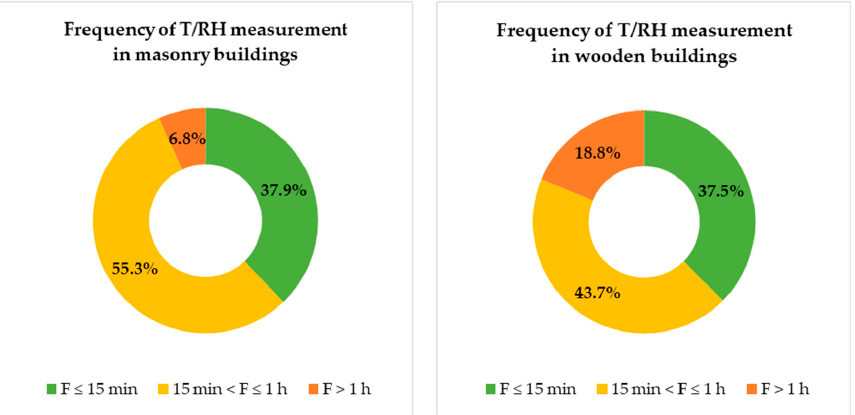
Figure 8. Comparison of the frequency of temperature (T) and relative humidity (RH) measurements in masonry and wooden religious buildings.